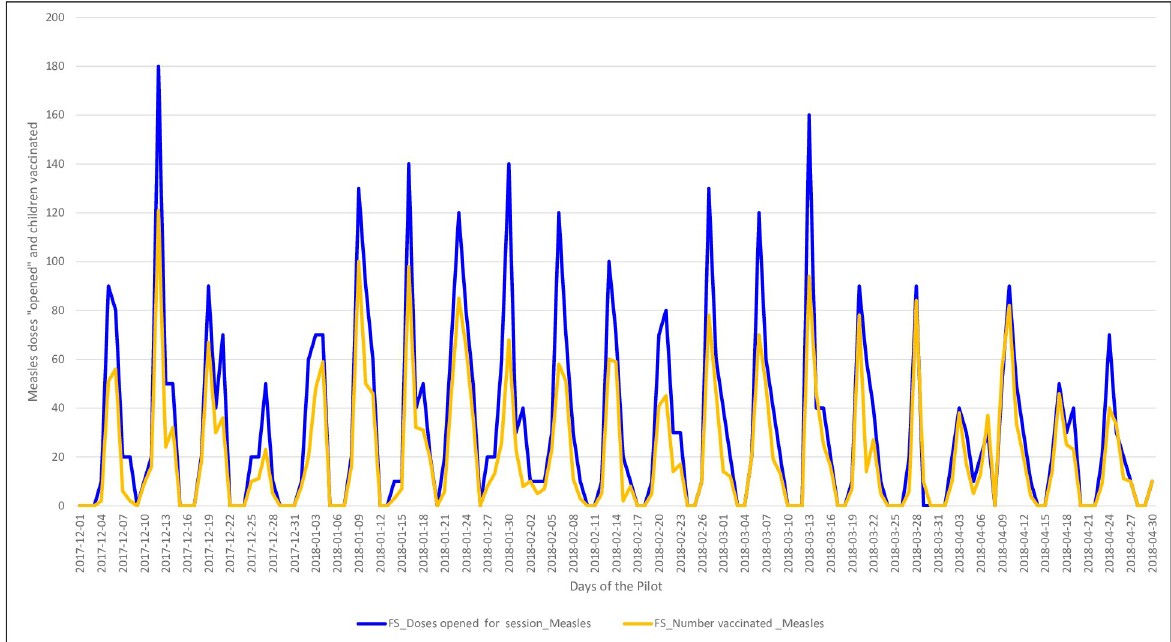
Fig 6. Number of children vaccinated with measles vaccine vs. number of measles vaccine doses opened during fixed-post vaccination sessions, during the 151 days of the pilot.